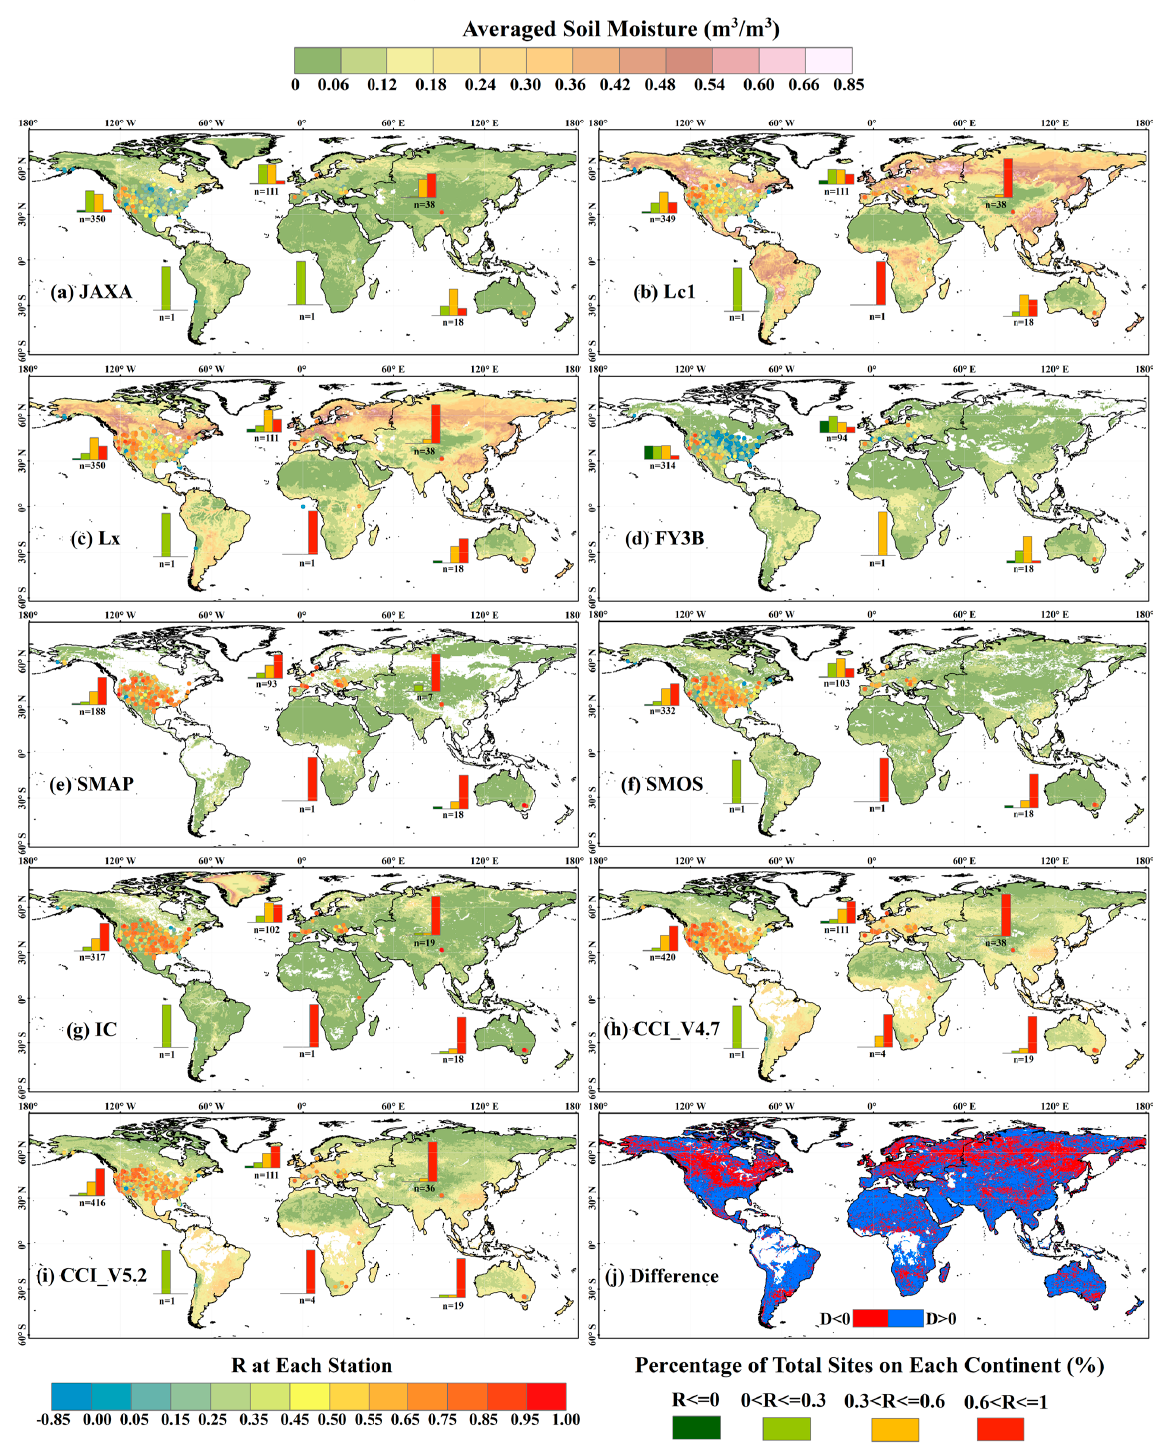
Figure 4. ( a – i ) are the global distributions of R and mean SM (m 3 m − 3 ) for each product from 2016 to 2018 (n is the number of total sites on each continent). ( j ) represents the difference between the averaged CCI_V5.2 and CCI_V4.7 (D means the